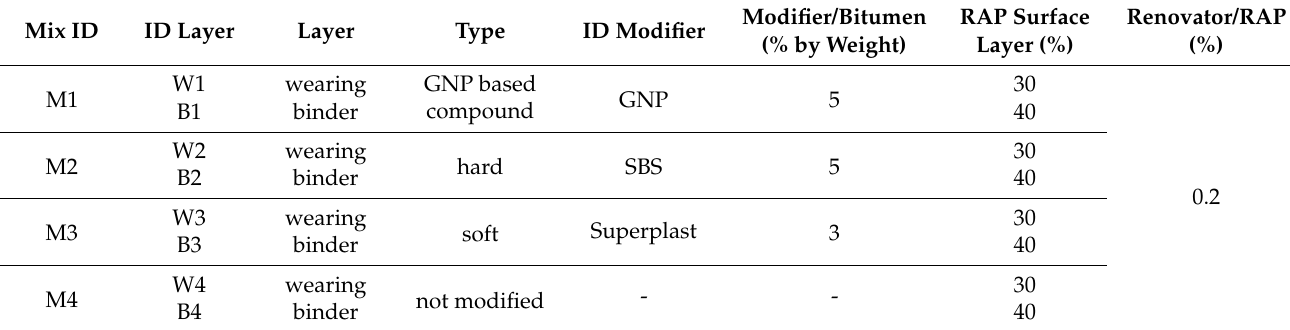
Table 1. Composition of the tested